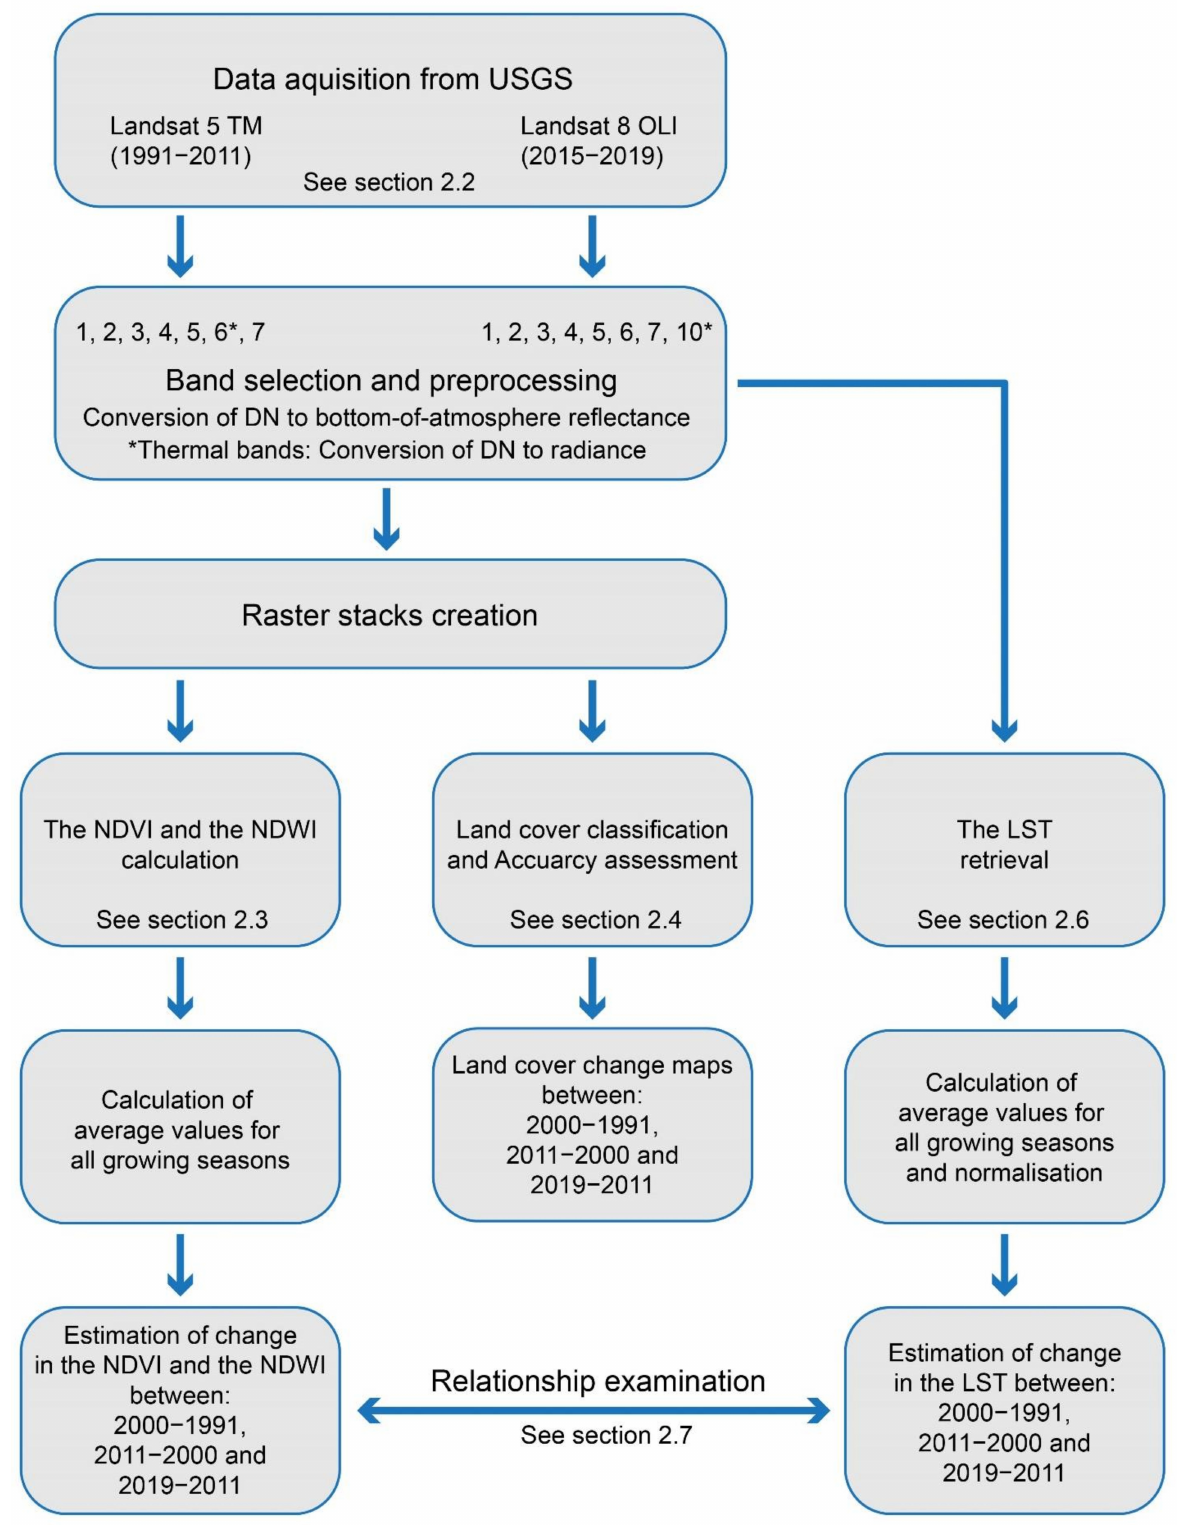
Figure 3. Methodological workflow of the